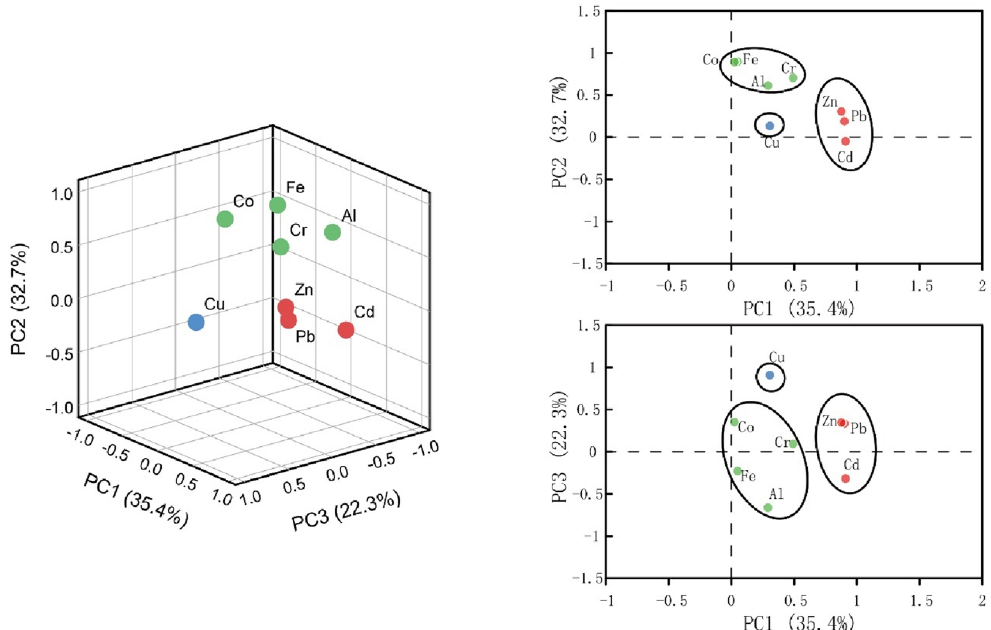
Figure 3. PCA results of the elements in the ED-W. Left: 3D loading plot of the elements; right: 2D loading plots on PC1–PC2 and